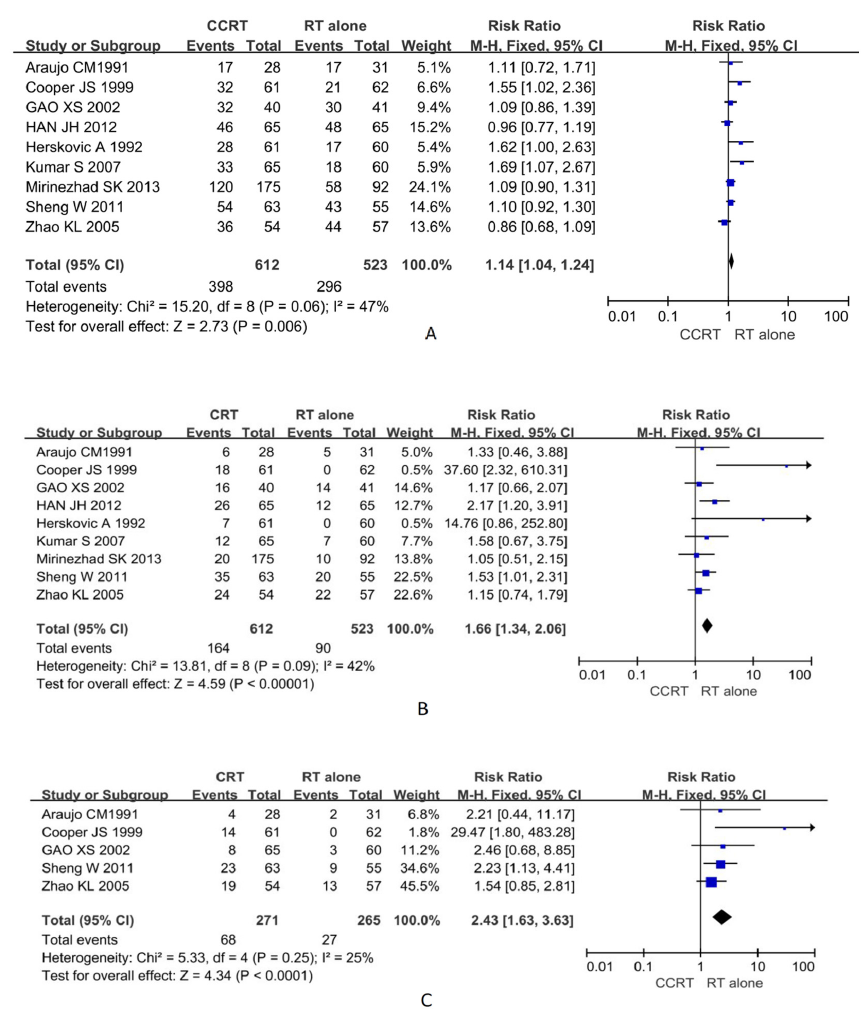
Fig 2. Forest plot comparing survival rates for the CCRT group and the RT alone group. The blue squares represent study-specific relative risks (RR), the horizontal lines represent 95% CIs, and the black diamonds represent the summary of RR. (A) Comparison of 1-year survival rate. (B) Comparison of 3-year survival rate. (C) Comparison of 5-year survival rate.